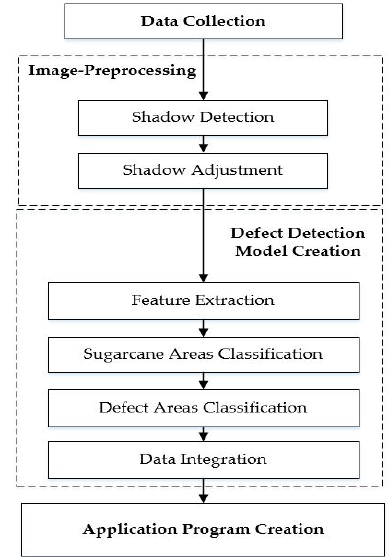
Figure 1. The conceptual framework of the defect detection model.